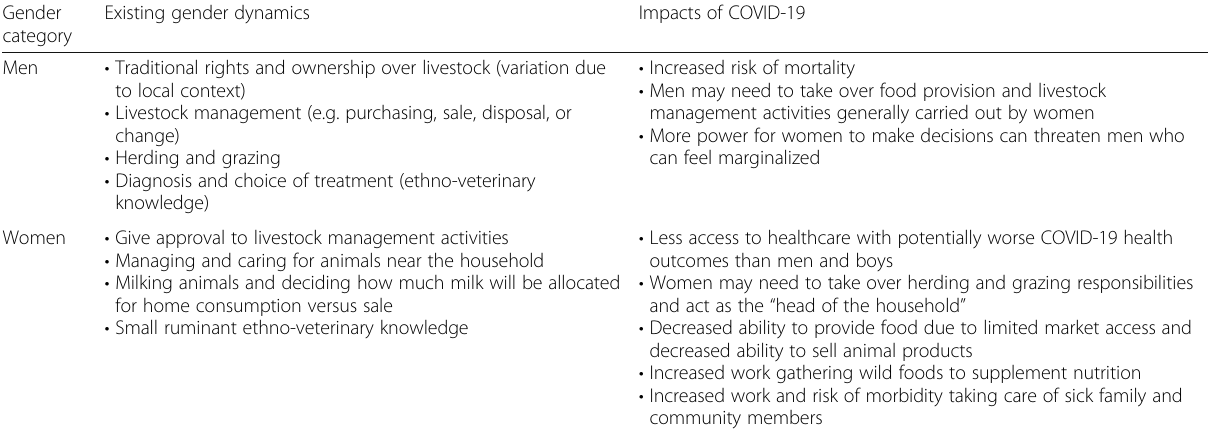
Table 6 Existing gender dynamics amongst pastoralists with predicted impacts of COVID-19 (Flintan 2008; Kristjanson et al. 2014) Gender Existing gender category